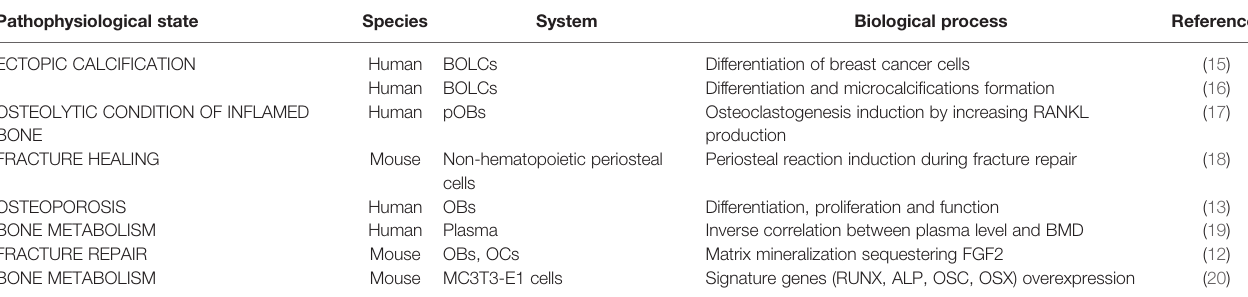
TABLE 1 | Pentraxin 3 (PTX3) involvement in pathophysiological state of bone tissue ’ s metabolism. Pathophysiological